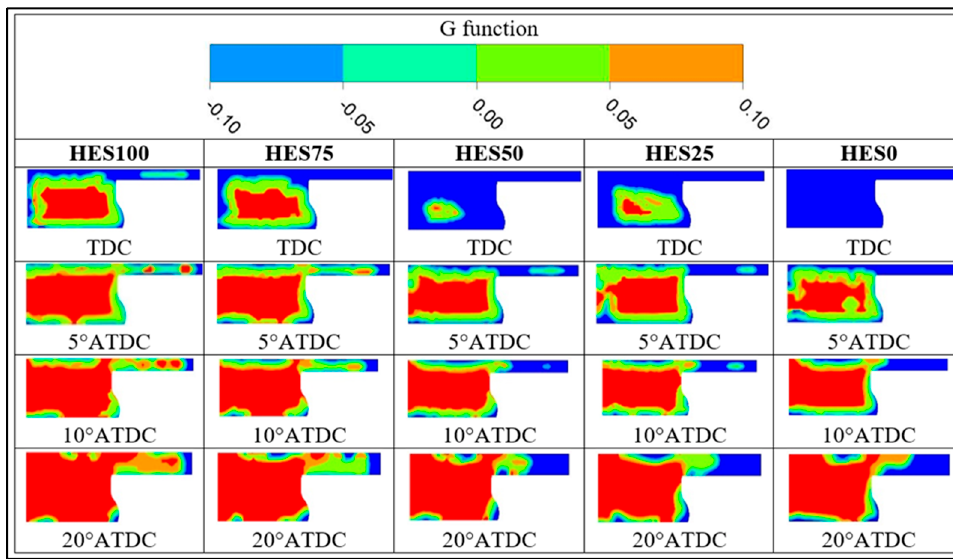
Figure 25. G function distributions for the different HES cases.